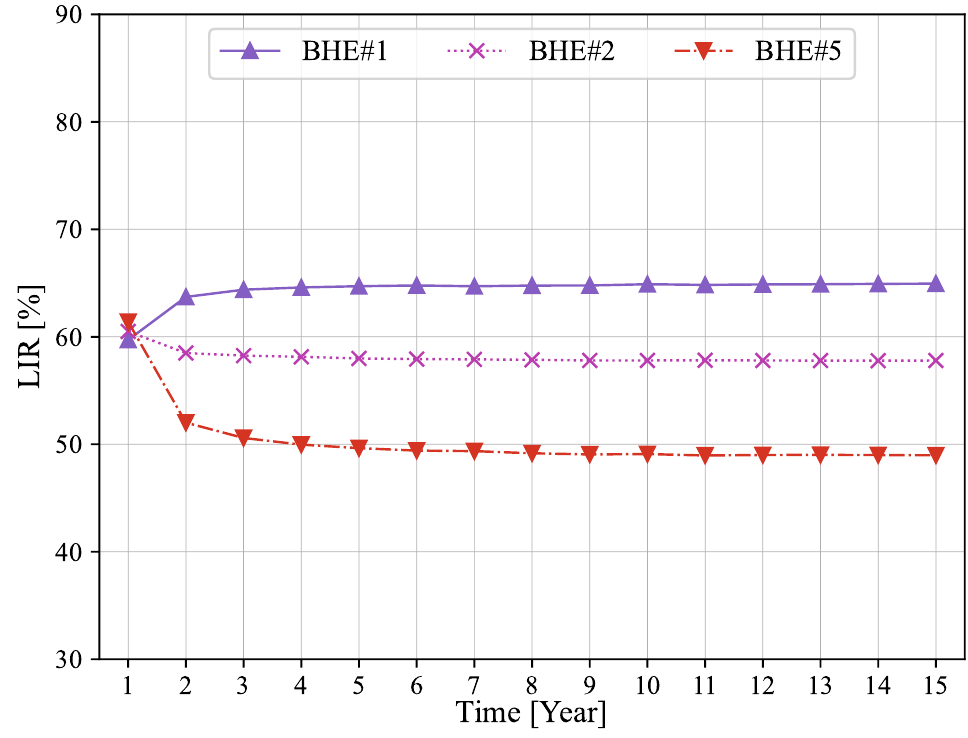
Figure 12. Evolution of the load imbalance ratio of the selected MSBHE over 15